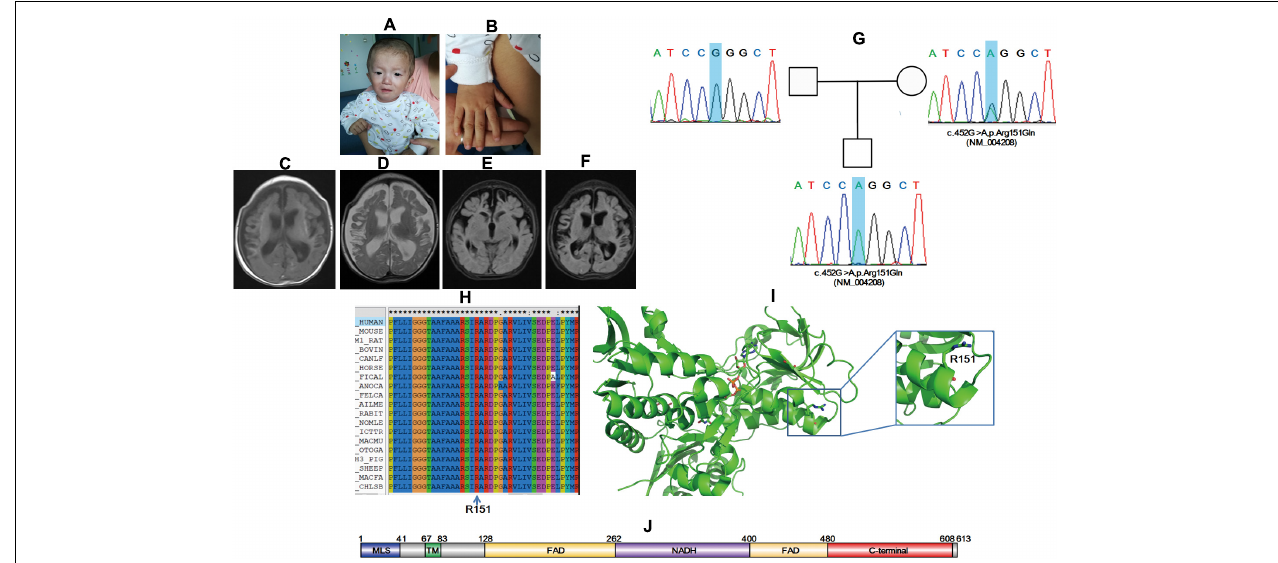
FIGURE 2 | AIFM1 variant induces X-linked COXPD6 in a 3-month-10-day-old male infant. Premature anterior fontanelle closure (A) , hand clenching (A) , and adducted thumb were noted (B) . Softened left frontal lobe and dilation of lateral ventricles were found (C–F) . Sanger sequencing showed that the proband had a novel mutation inherited form his mother (G) . Amino sequence alignment indicated that the mutation site is conserved among different species (H) and structural modeling revealed that R151 locate on an α helix, and the R151E variant might be pathogenic (I) . Schematic map of protein domains for AIFM1 (J) .